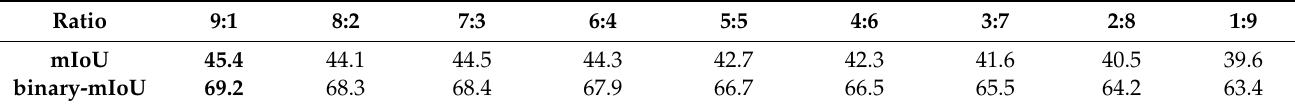
Figure 4. Qualitative results of our model in 1-way 1-shot segmentation on PDID-5 i . Table 4. Ablation experiments on different